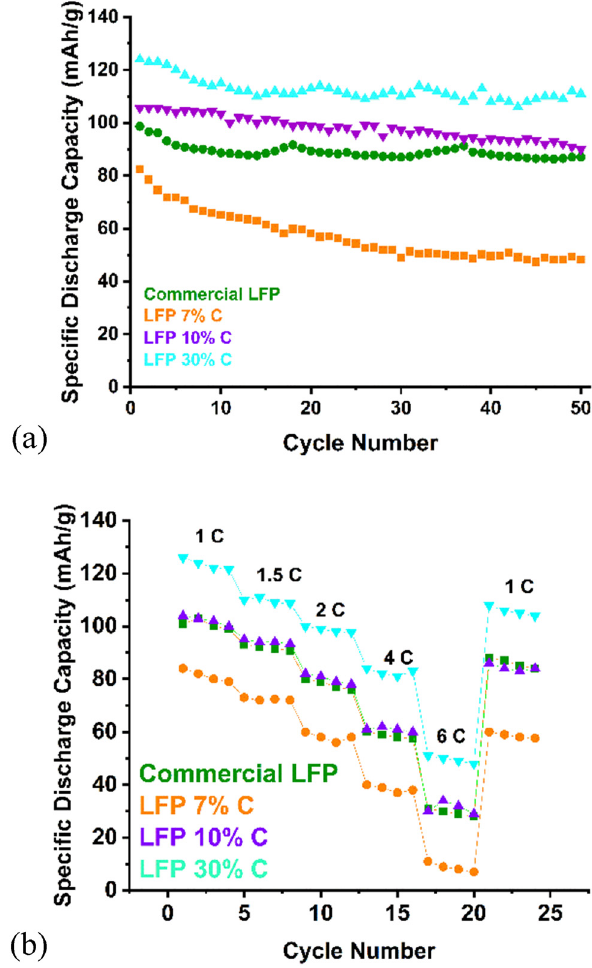
Figure 9: ( a ) Cycle performance and ( b ) rate performance test of LiFePO 4 /C at various carbon